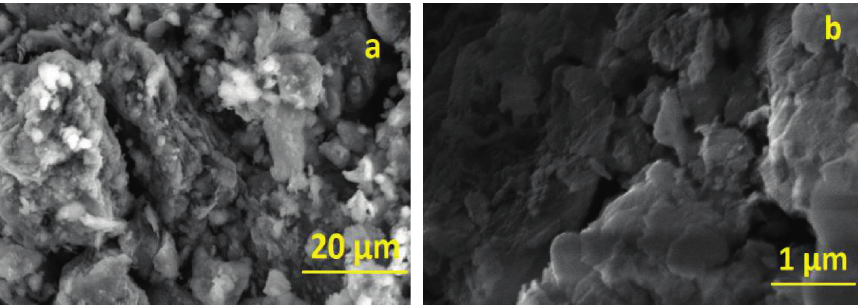
Figure 9: SEM image of raw clay ANb before (a) and after (b) MR-dye